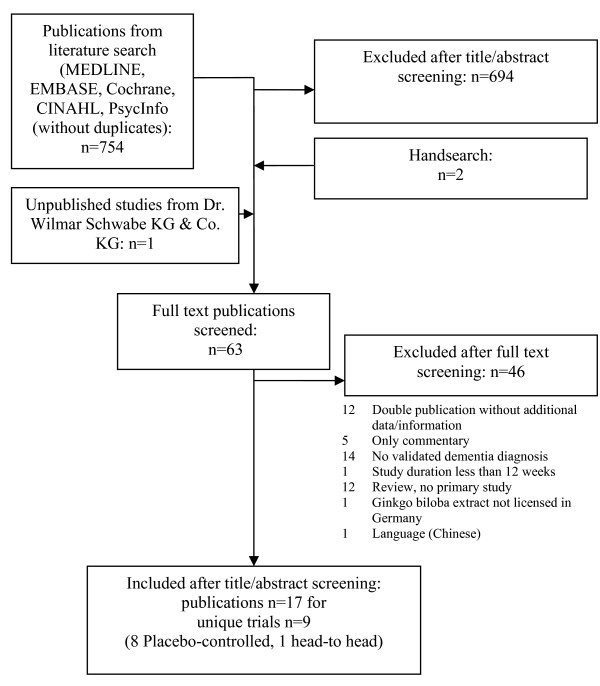
Flow chart of study identification and selection.